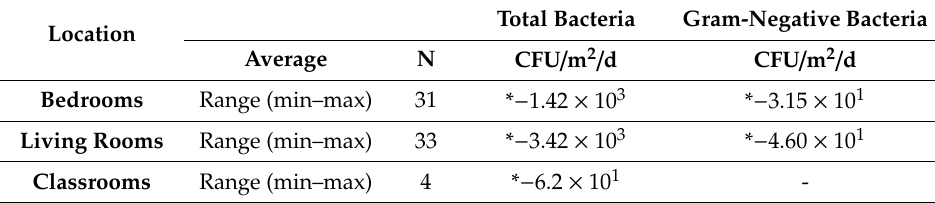
Table 3. Bacteria contamination (CFU / m 2 / d) in each studied